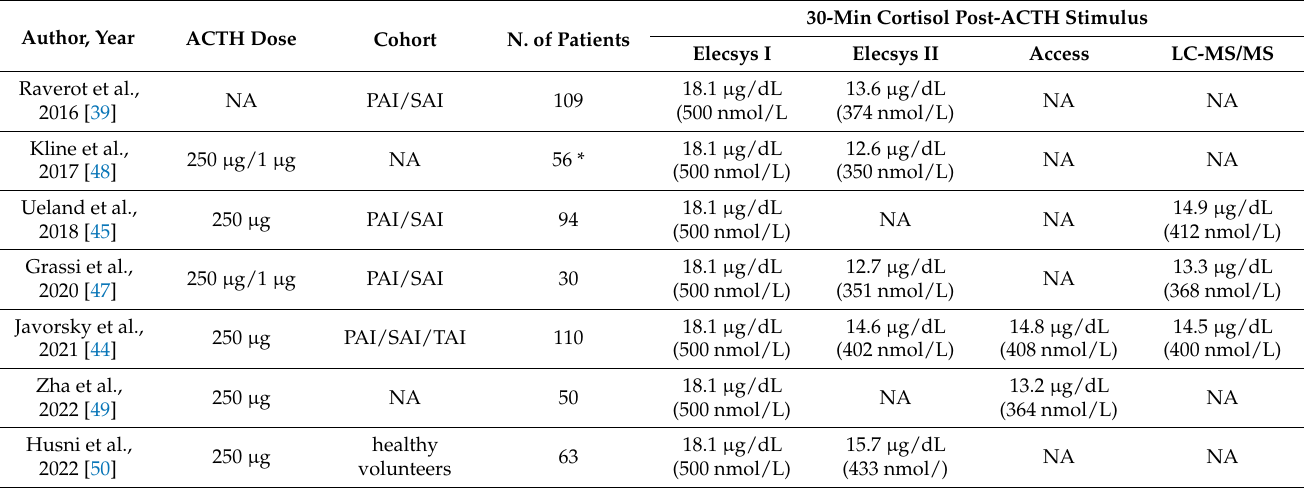
Table 1. Summary of the available studies in the literature on new cortisol